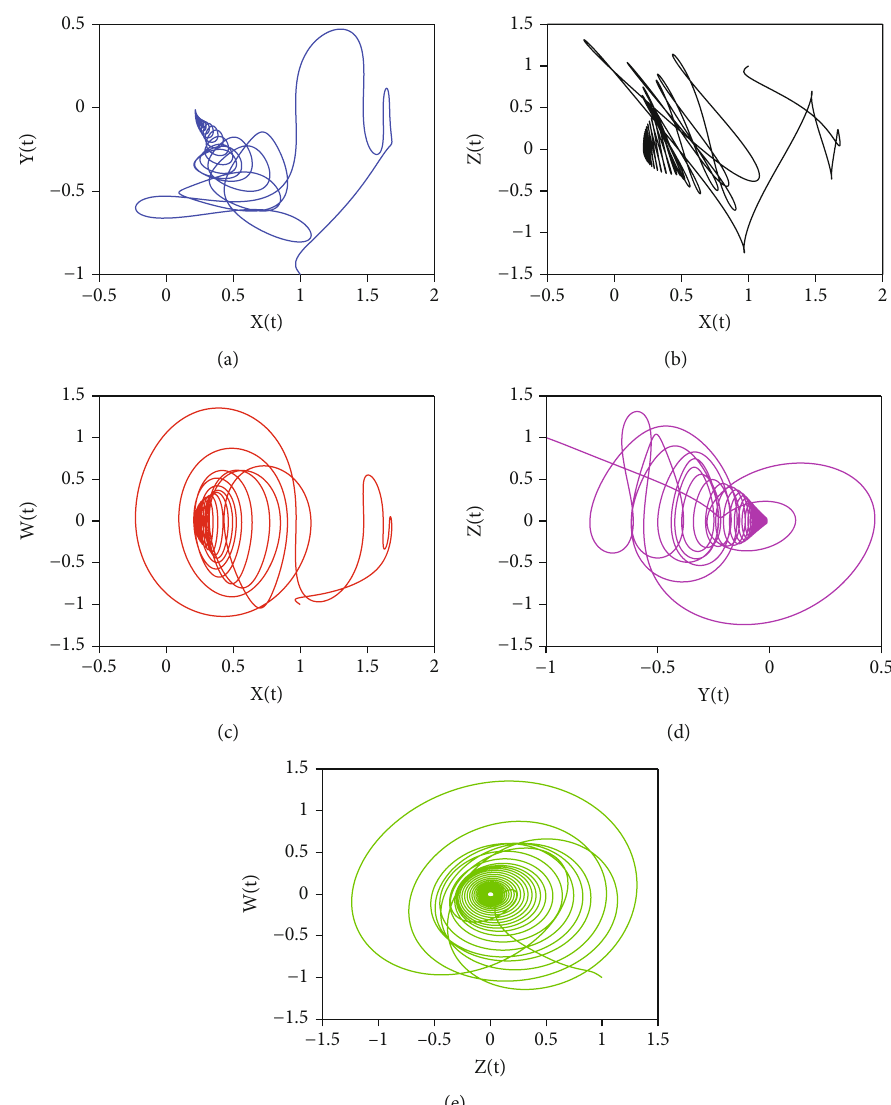
Figure 6: The behavior of di ff erent state variables of system 1 with fractional order ϖ = 0 : 98 and the parameters are considered as c = d = 2